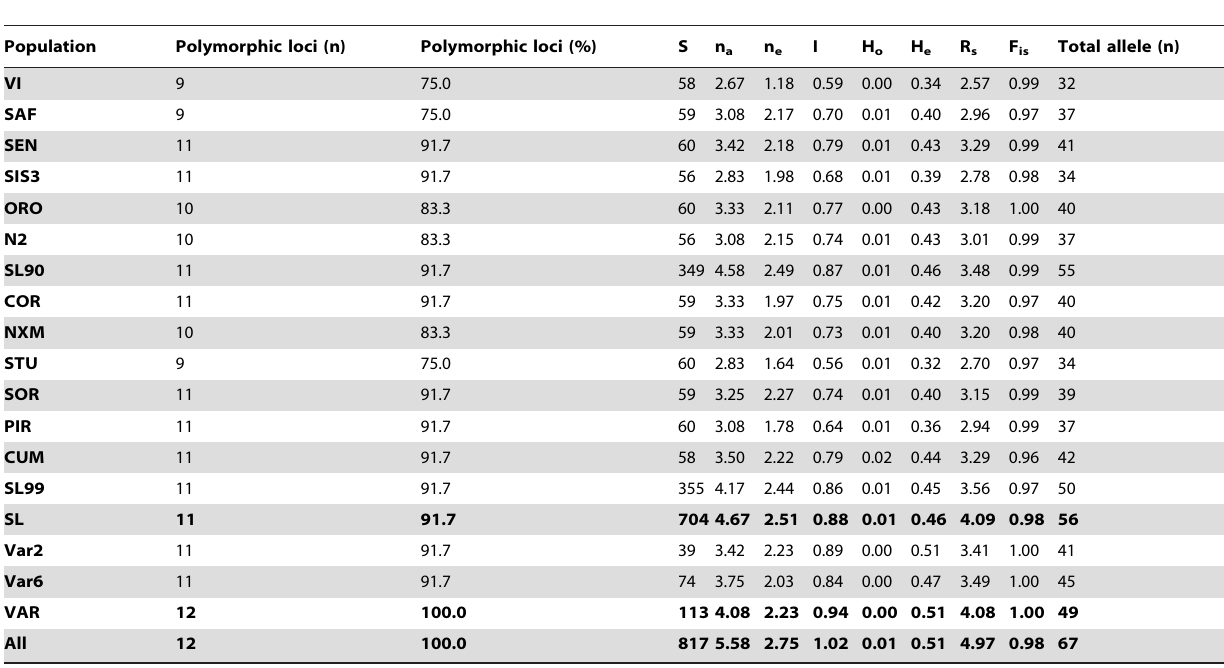
Table 3 . Summary statistics calculated for each population (12 SL, Var2 and Var6), for each group and sub-group (SL and VAR, SL90 and SL99,) and for the whole sample.